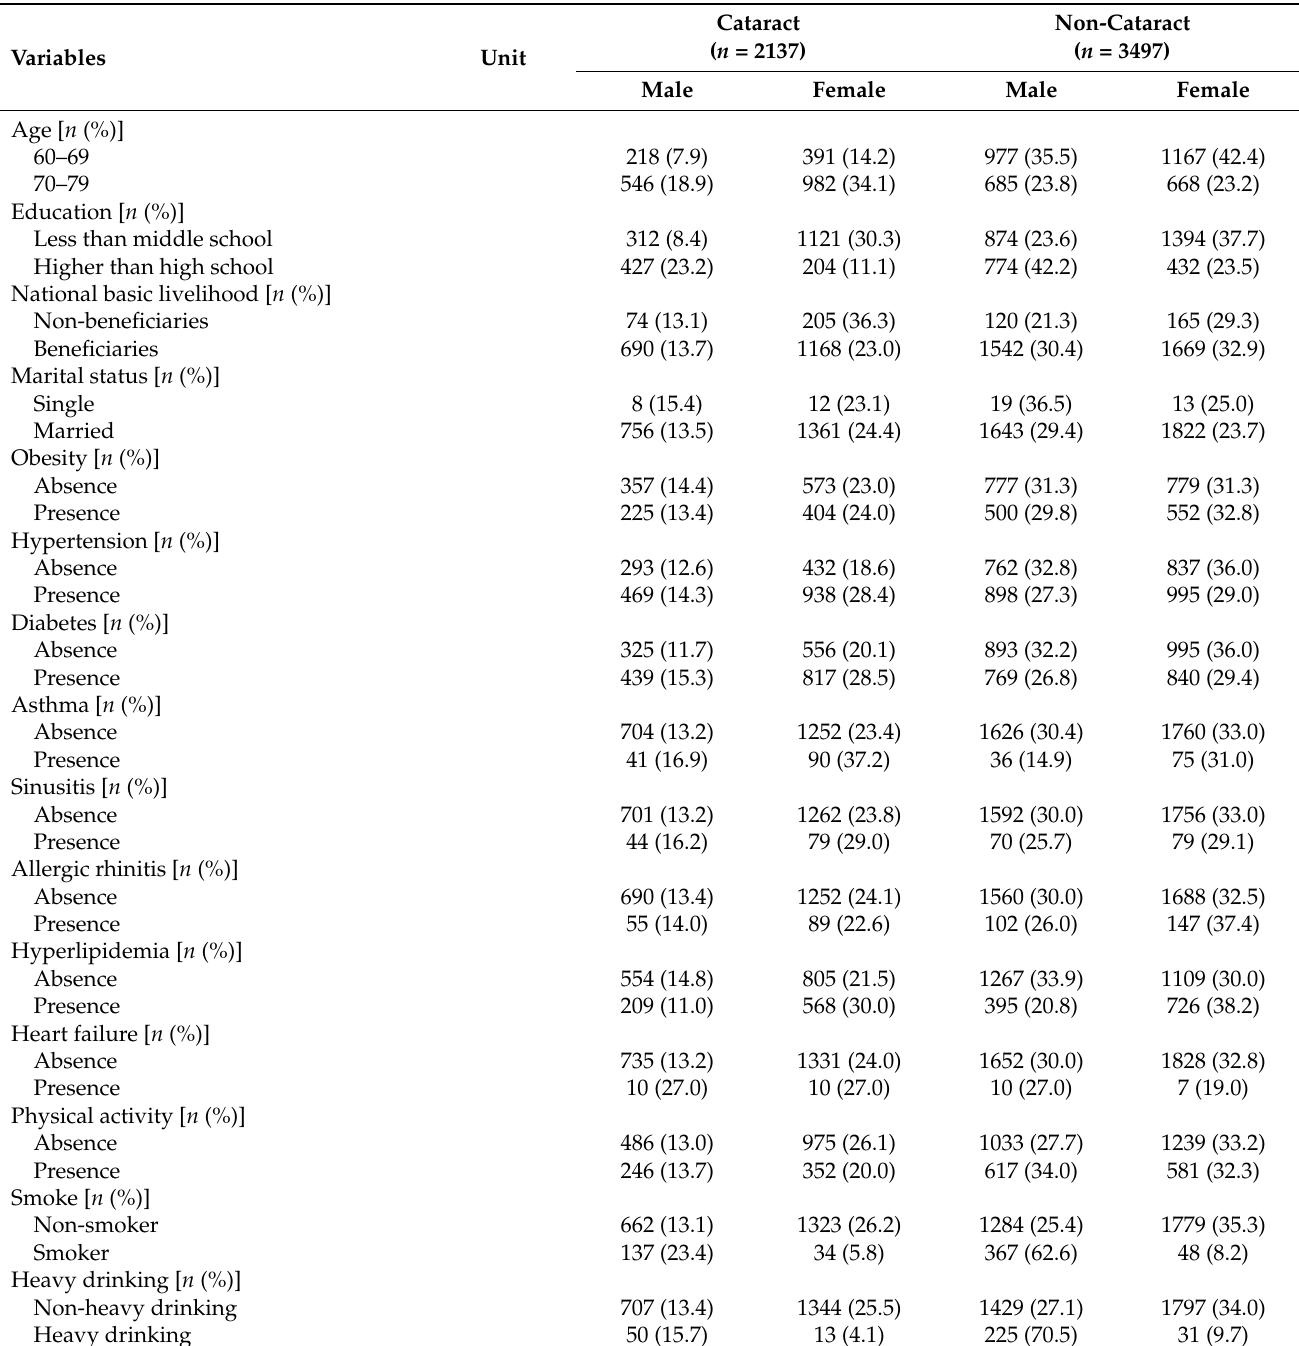
Table 1. Basic characteristics of the study